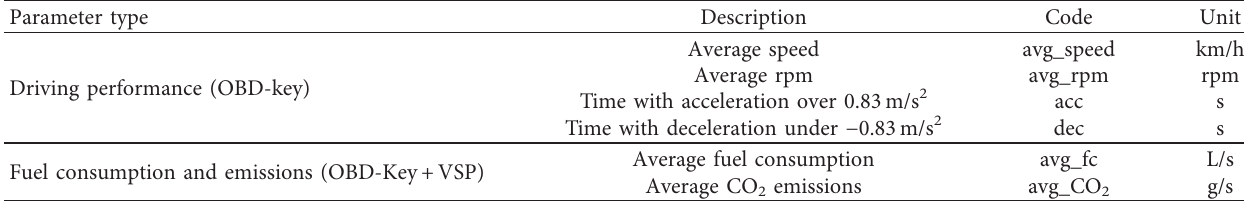
Table 4: Description of the parameters selected for measuring effects of eco-driving.